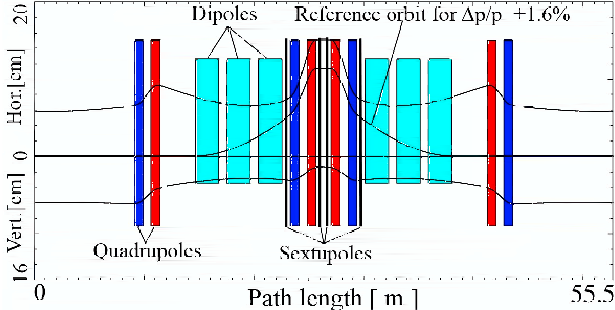
FIG. 3. (Color) Beam envelopes and reference orbit for (cid:1) p=p (cid:4) (cid:7) 1 : 6% in one quarter of the